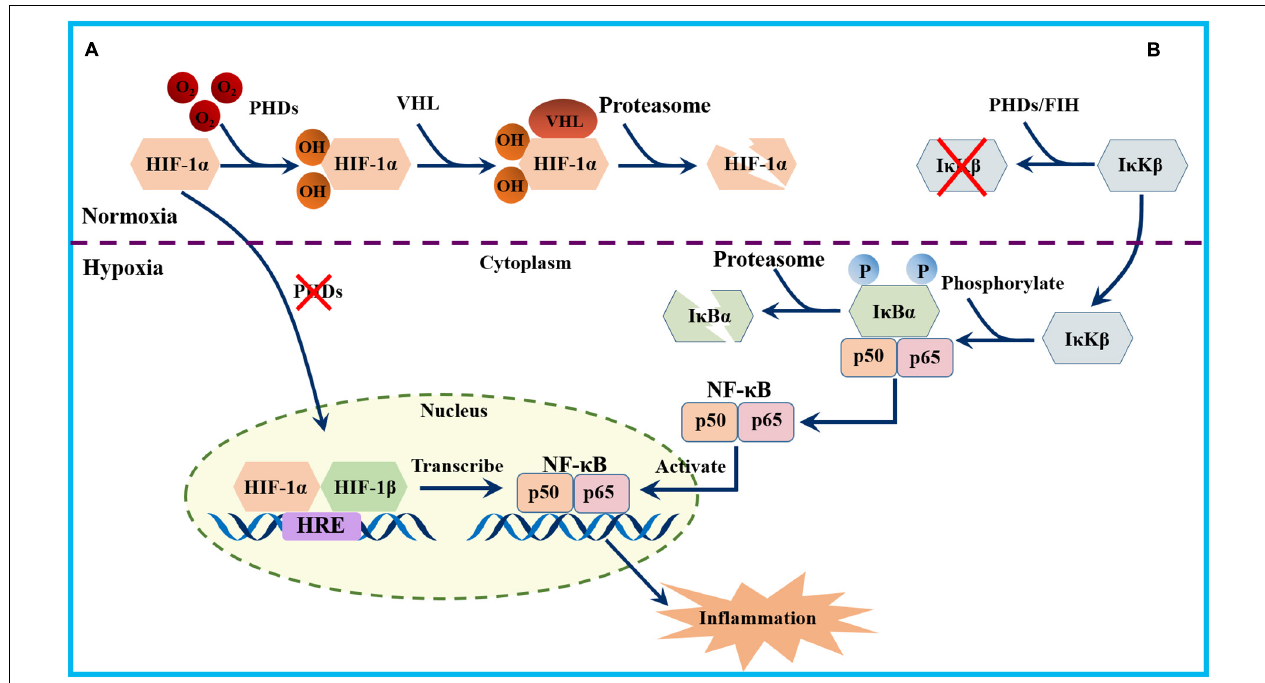
FIGURE 3 | Schematic diagram of the NF-kB activation pathways. (A) Under hypoxia, HIF-1 α is stabilized and translocate to the nucleus, dimerizing with the β subunit and binds to HREs in the promoters of NF- κ B to initiate its transcription. (B) Under normoxia, PHDs and factor inhibiting hypoxia-inducible factor (FIH) prevent the activation of I κ B β . During hypoxia, I κ K β phosphorylate the NF- κ B inhibitor I κ B α , which results in its ubiquitylation and subsequent proteasomal degradation. Dissociation of I κ B α allows the nuclear translocation of the NF- κ B heterodimer and the transcription of its target